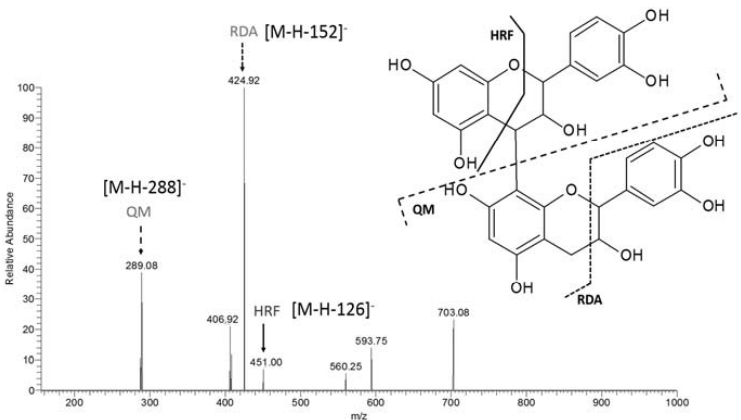
Figure 3. MS/MS spectrum of the ion at m / z 577 evidencing the main patterns of fragmentation of PAs. HRF = heterocyclic ring fission; RDA = Retro Dies-Alder fragmentation; QM = quinone-methide fragmentation.